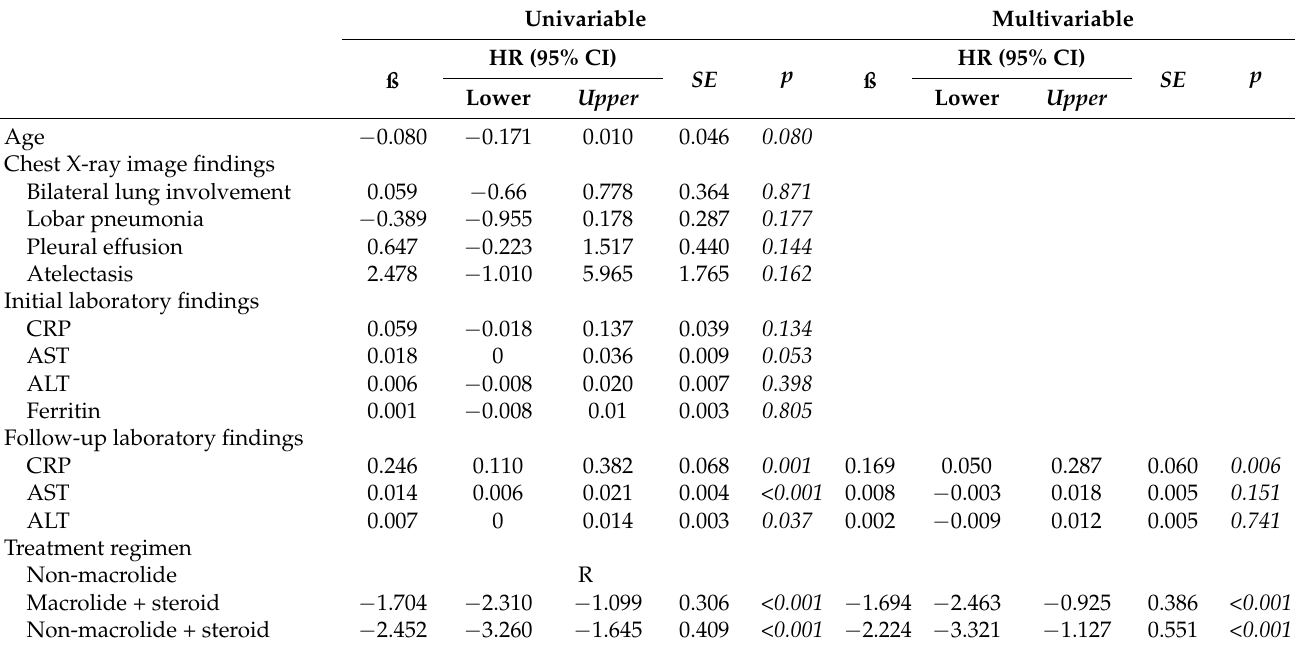
Table 3. Factors associated with fever duration after admission in children with macrolide-refractory Mycoplasma pneumoniae pneumonia. Univariable